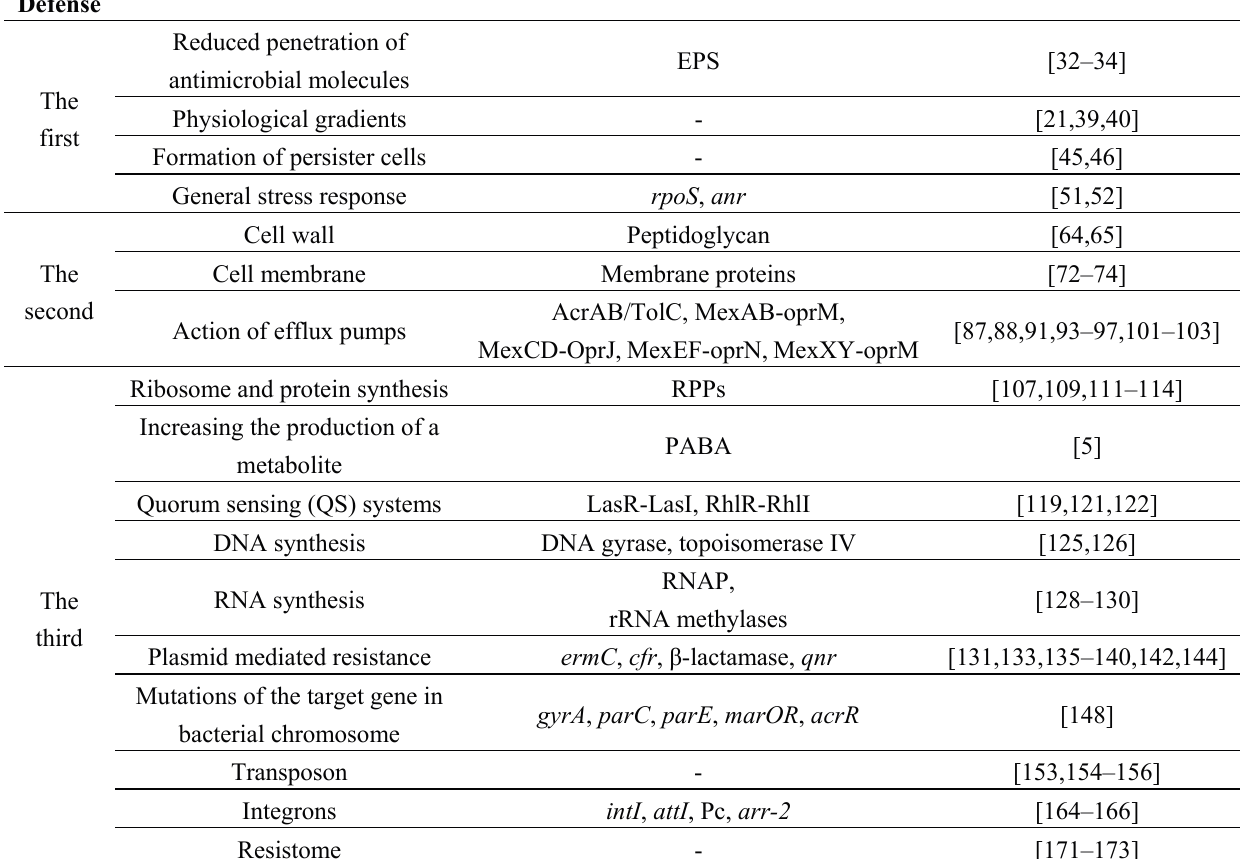
Table 1. Summary of the main resistance mechanisms in three lines of defense for bacteria to combat antimicrobial agents in this